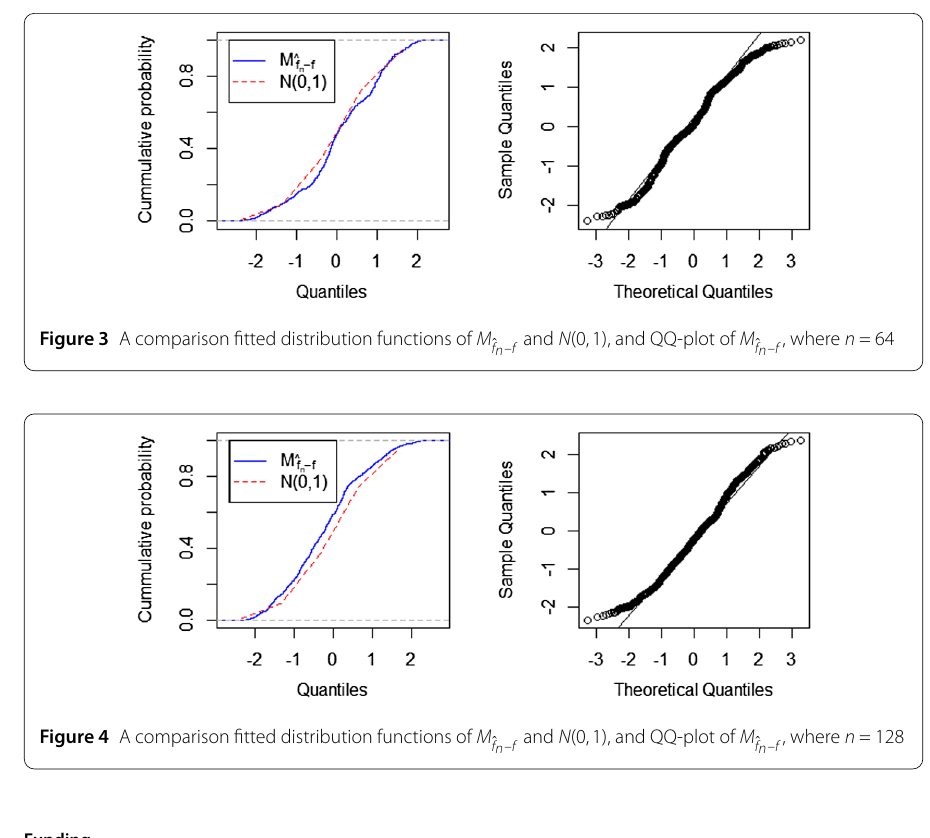
Figure 4 A comparison fitted distribution functions of M ˆ